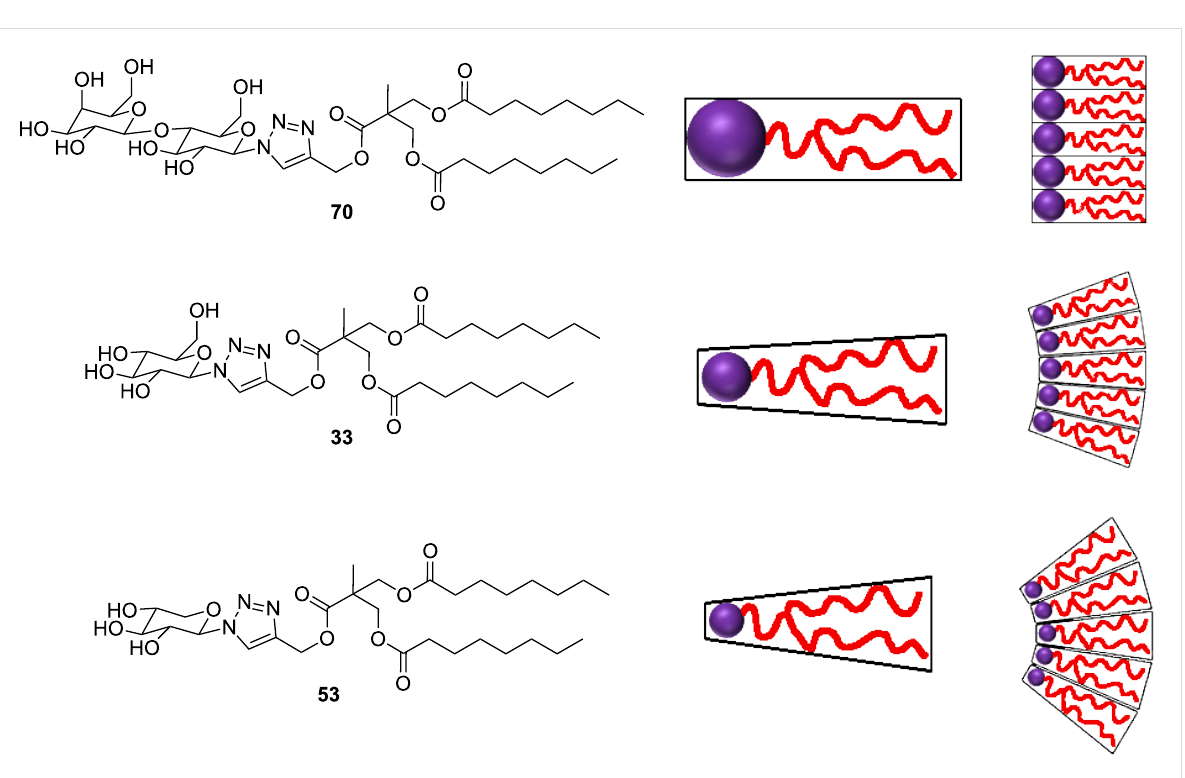
Figure 7: Differences in head group volume lead to differences in the curvature (and thus liquid-crystalline phase) of the self-assembled